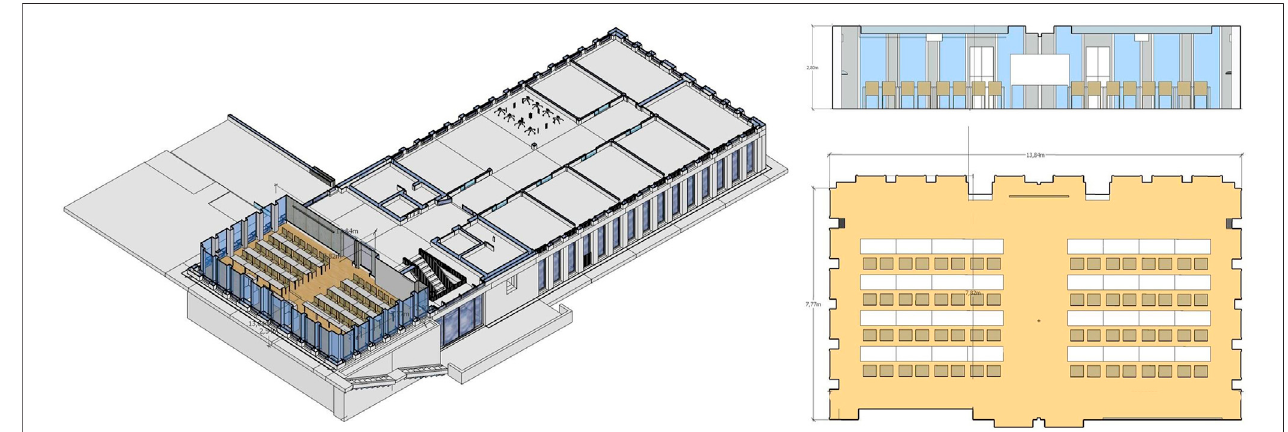
FIGURE7| DifferentviewsoftheacousticmodeloftheclassroomforDemonstratorB.Theclassroombelongstoabiggerbuilding,whichisnottakenintoaccount for this study.